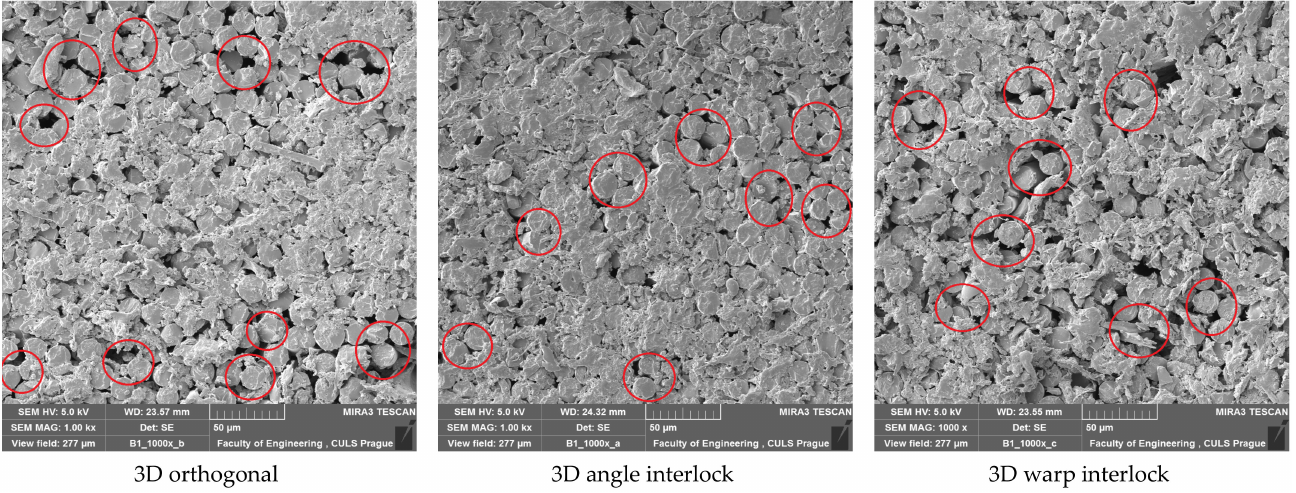
Figure 17. SEM images of impact-tested 3D woven composite samples prepared at 12 bar molding